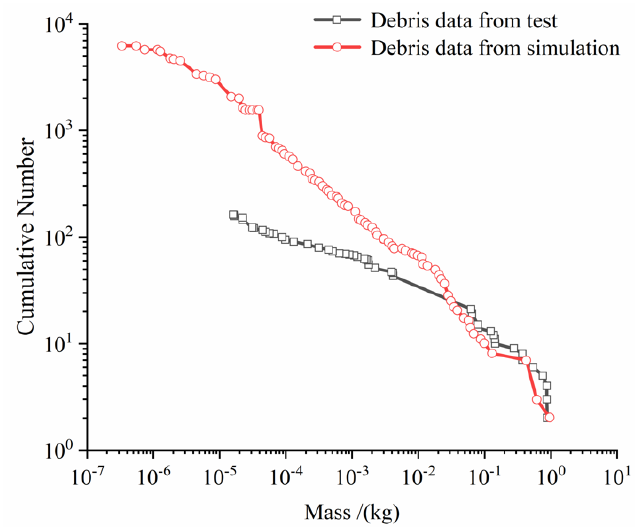
Figure 29. Comparison of fragment mass distribution of simulated satellite between simulation and test.